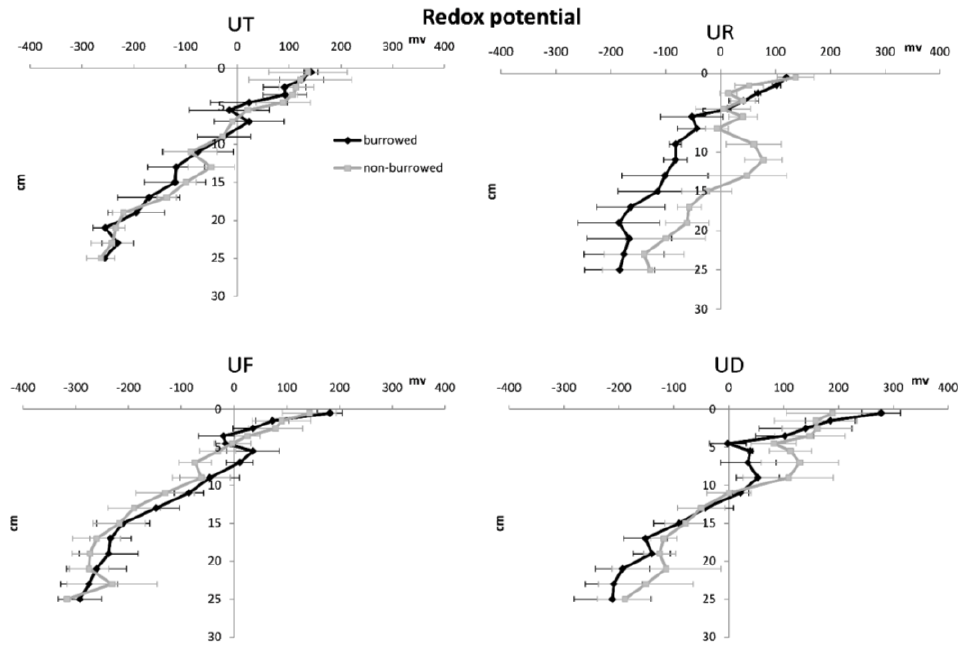
Figure 6. Vertical variation of redox potential in burrowed and non-burrowed sediments of U. triangularis (UT), U. rosea (UR), U. forcipata (UF) and U. paradussumieri (UD) habitat.